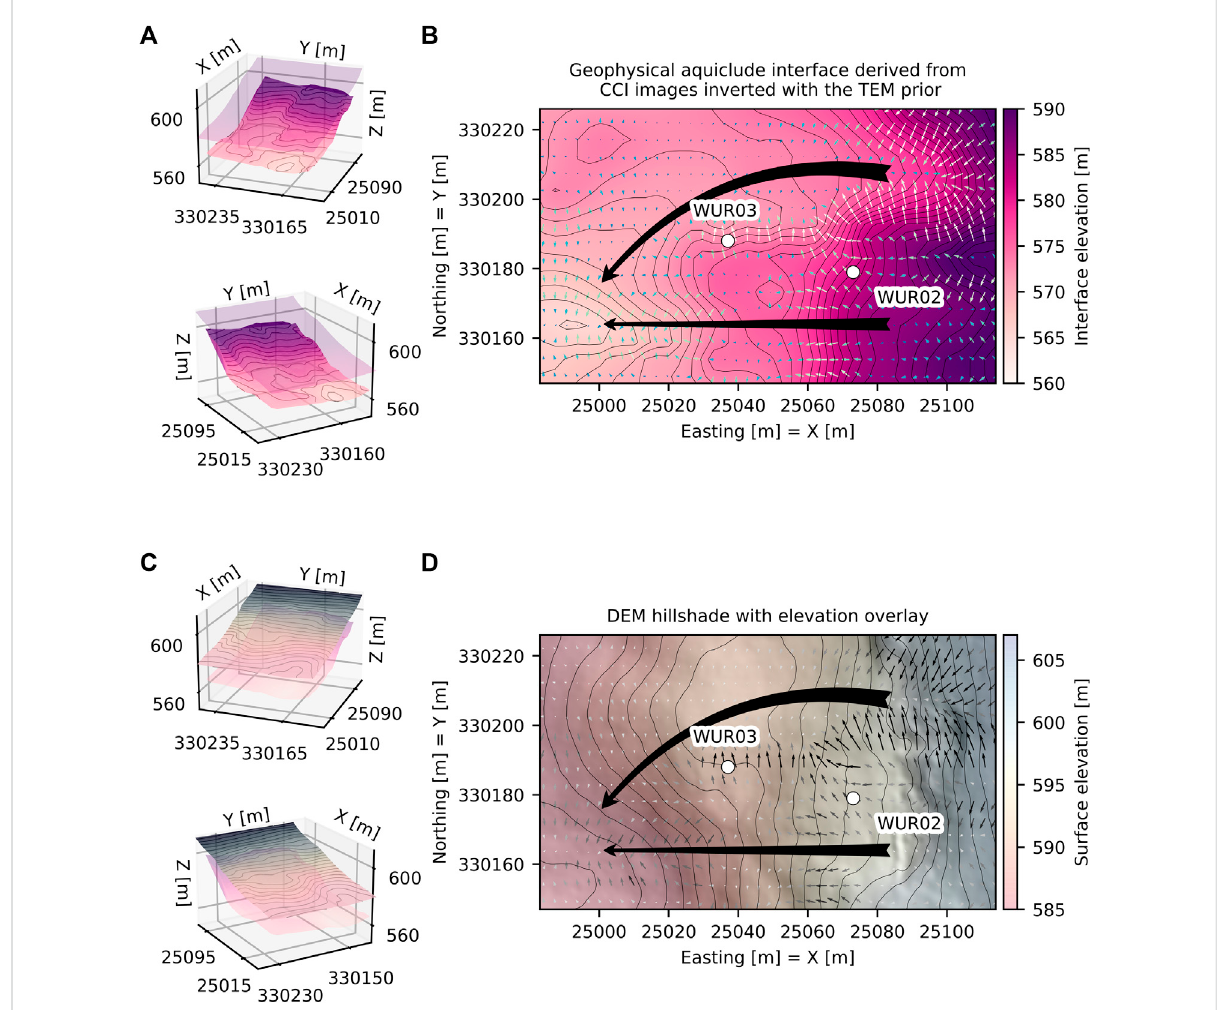
FIGURE 11 AquicludeinterfacederivedfromcombinationofCCI(usingtheTEMreference model)andRSTin (A) 3Drepresentation (greyshading indicates the DEM) and (B) as map with the corresponding gradient vector magnitudes (small regularly distributed and color-coded arrows) and interpreted preferentialwater- fl owpaths(blackarrows)superimposed onit. (C) and (D) presentthecorresponding3Dviewandmapofthecolor-codedsurface topography, again superimposing both the gradient vectors magnitudes and preferential fl ow paths from the aquiclude